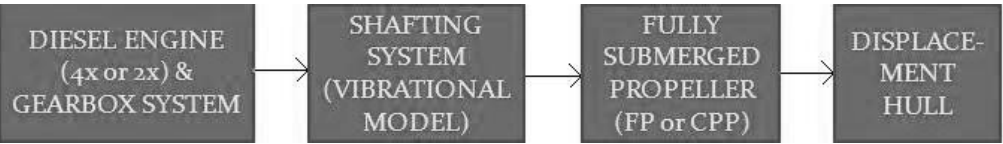
Figure 1. Conventional marine propulsion plant.